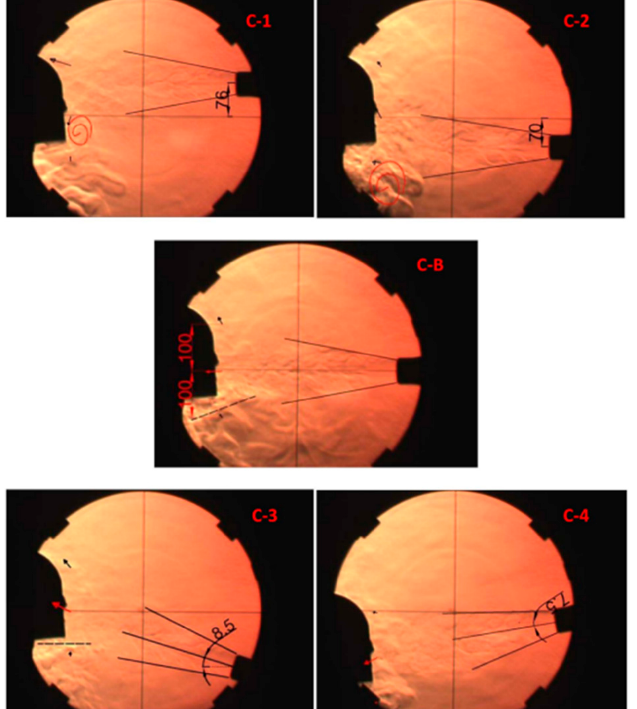
Figure 15. Turbulence creation for different nozzle positions [145]. Nozzle Position: C-1 Perpendicular but above the nose; C-2 Perpendicular but below the nose; C-B Exactly perpendicular to the nose; C-3 Inclined towards the top of the nose; C-4 Inclined towards the bottom side of the